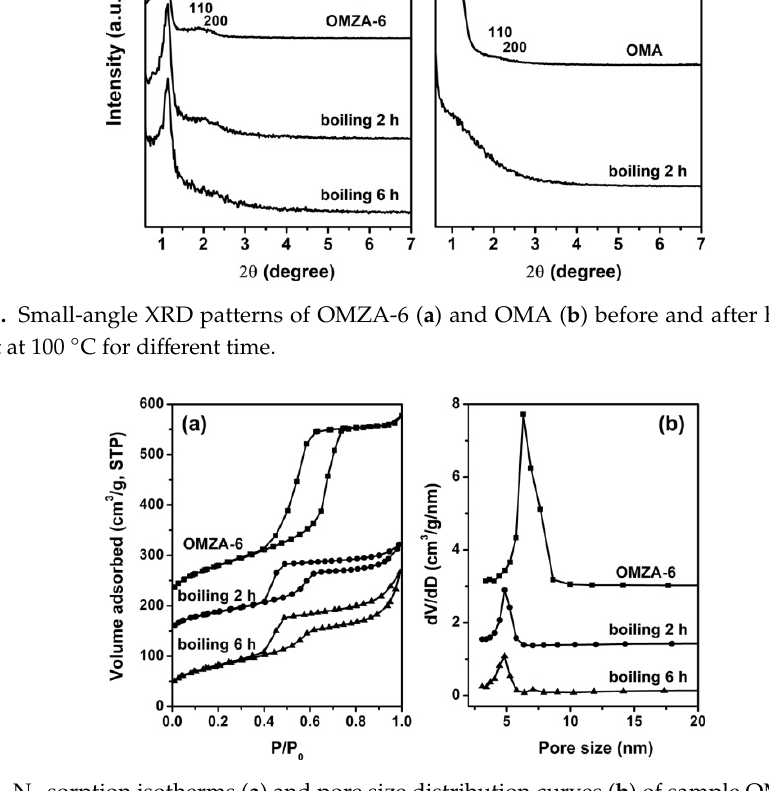
Figure 11. N 2 sorption isotherms ( a ) and pore size distribution curves ( b ) of sample OMZA-6 before and after hydrothermal treatment at 100 °C for different time. For clarity, in ( a ), the isotherms of untreated OMZA-6 and OMZA-6 hydrothermally treated for 2 h are offset along the Y axis by 200 and 100 cm 3 /g, respectively. In ( b ), the Y axis values are increased by 3.1 and 1.5 cm 3 /g, respectively. Table 3. The textural properties of OMZA-6 before and after hydrothermal treatment at 100 °C for different time. a